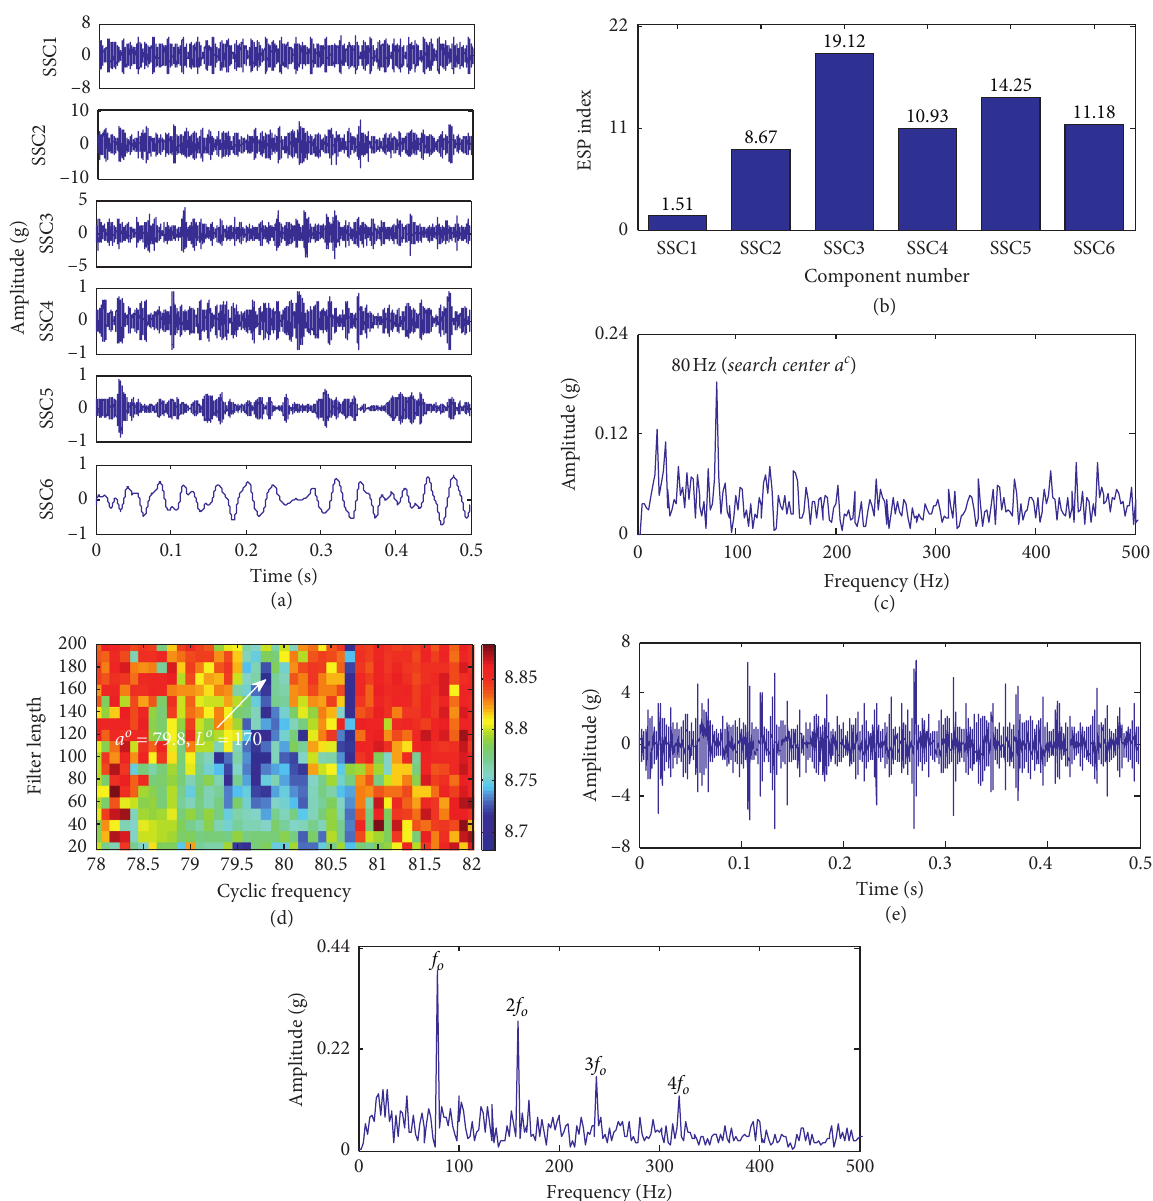
Figure 21: Analysis results of engineering signal by the proposed strategy: (a) the RSSD preprocessing results; (b) the ESP indexes of obtained components; (c) the envelope spectrum of SSC3; (d) the grid search result; (e) the waveform of deconvolution signal; (f) the envelope spectrum of deconvolution